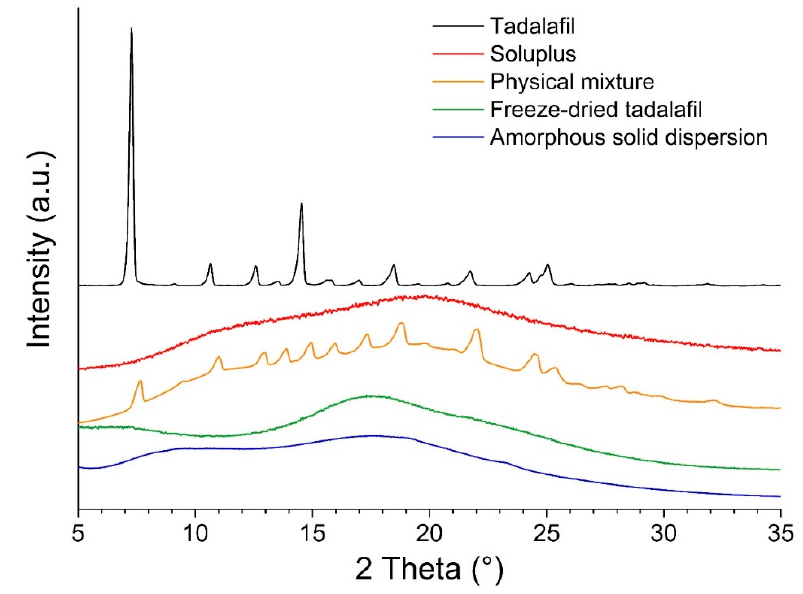
Figure 3. X-ray diffraction patterns of all formulations, tadalafil and Soluplus ® . Figure 3. X-ray di ff raction patterns of all formulations, tadalafil and Soluplus ®